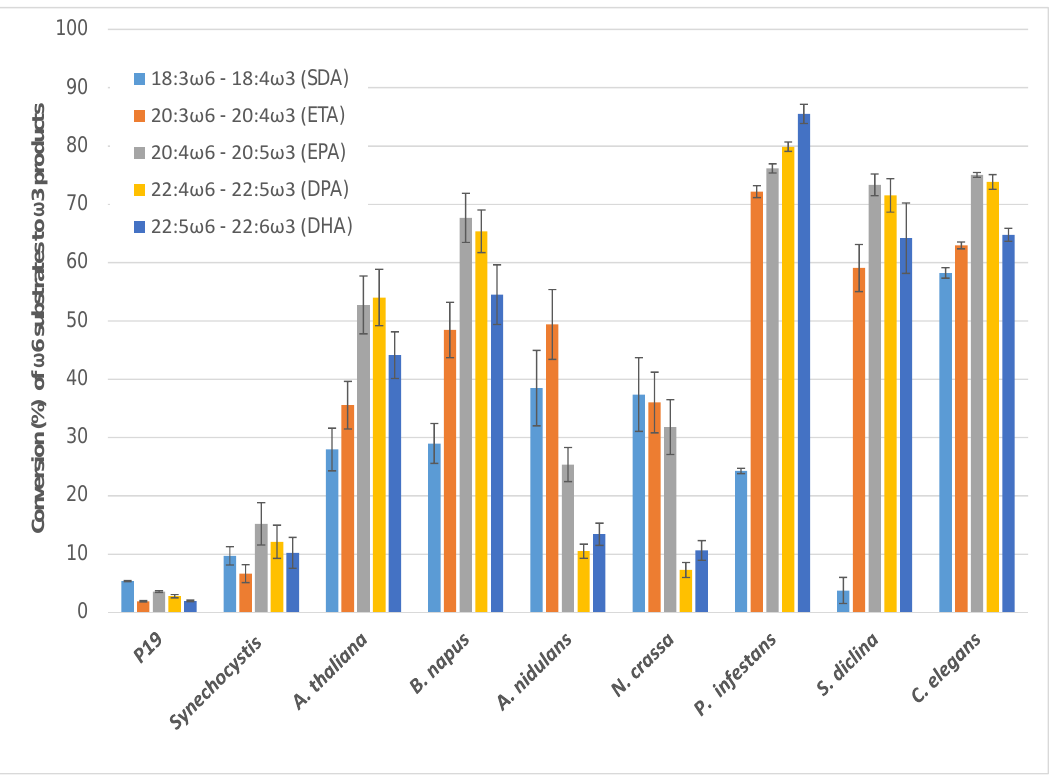
Figure 7. Competition for ω 6-fatty acid substrates (18:3 ω 6, 20:3 ω 6, 20:4 ω 6, 22:4 ω 6, 22:5 ω 6) by ω 3-desaturases from various sources transiently expressed in N. benthamiana . Error bars represent the standard deviations of the means from triplicate